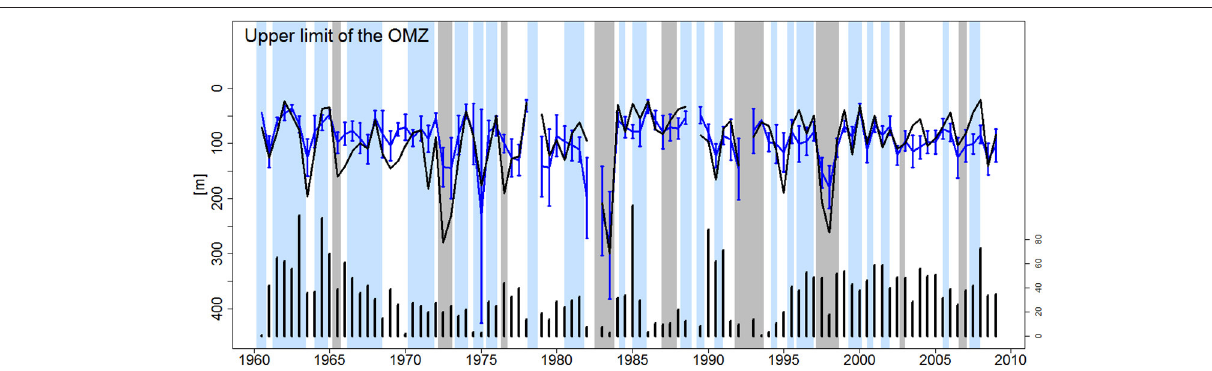
DO concentration within the OMZ ( Figures 3 – 5 ), the model represented realistically the oxygen changes during ENSO